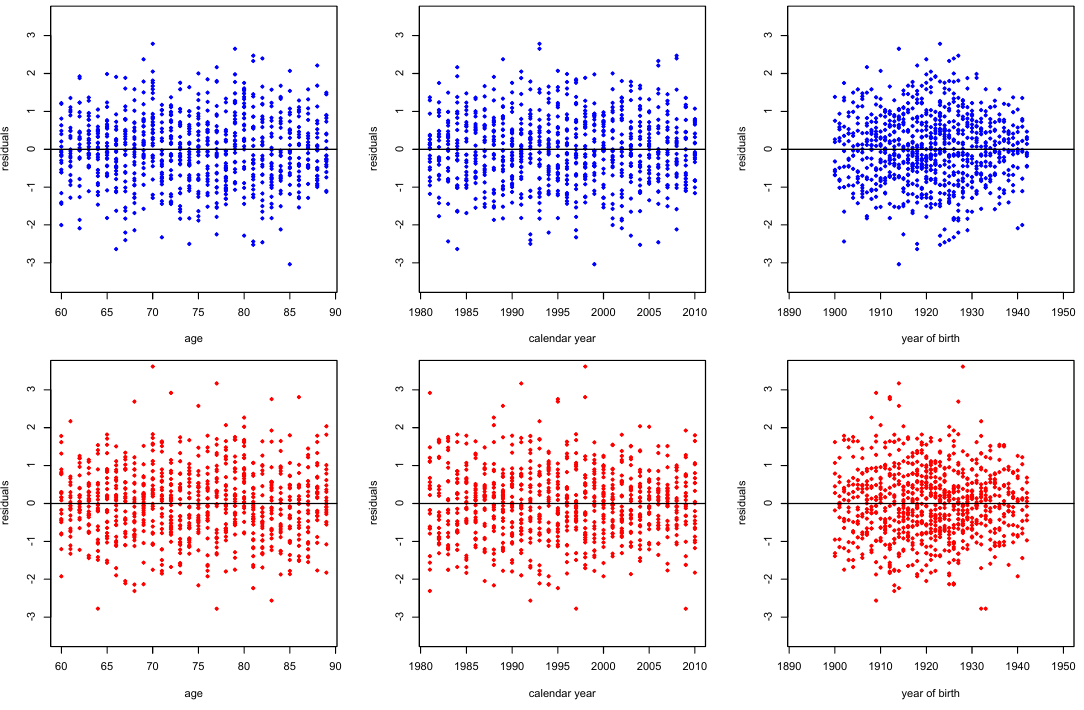
Figure 14. Residuals deviance of M 7 for males ( top panels) and females ( bottom panels) in Greece. Period 1981–2010, ages